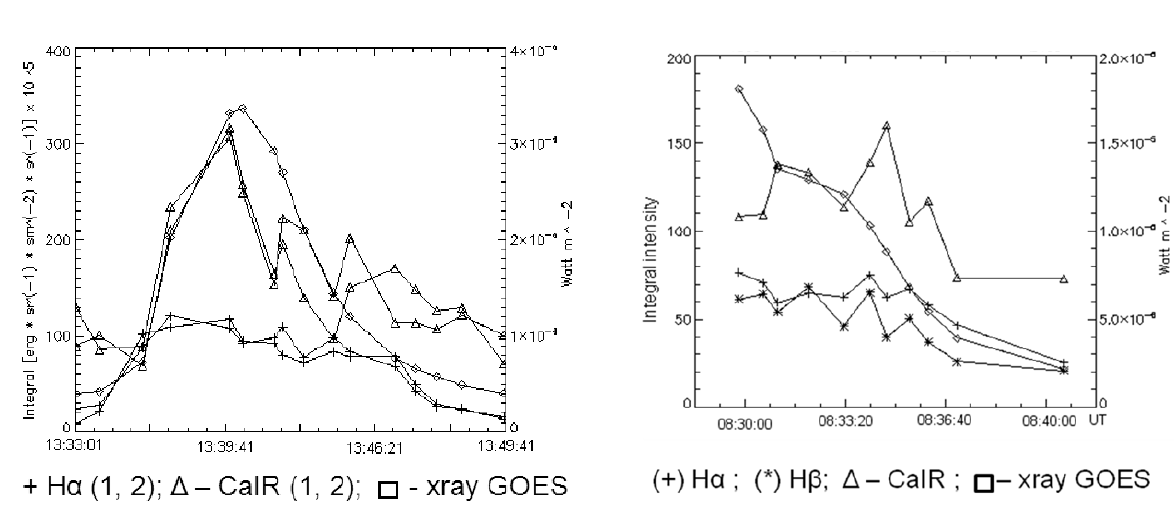
Figure 4. Graphs of integrated radiation intensity and X-ray flux versus